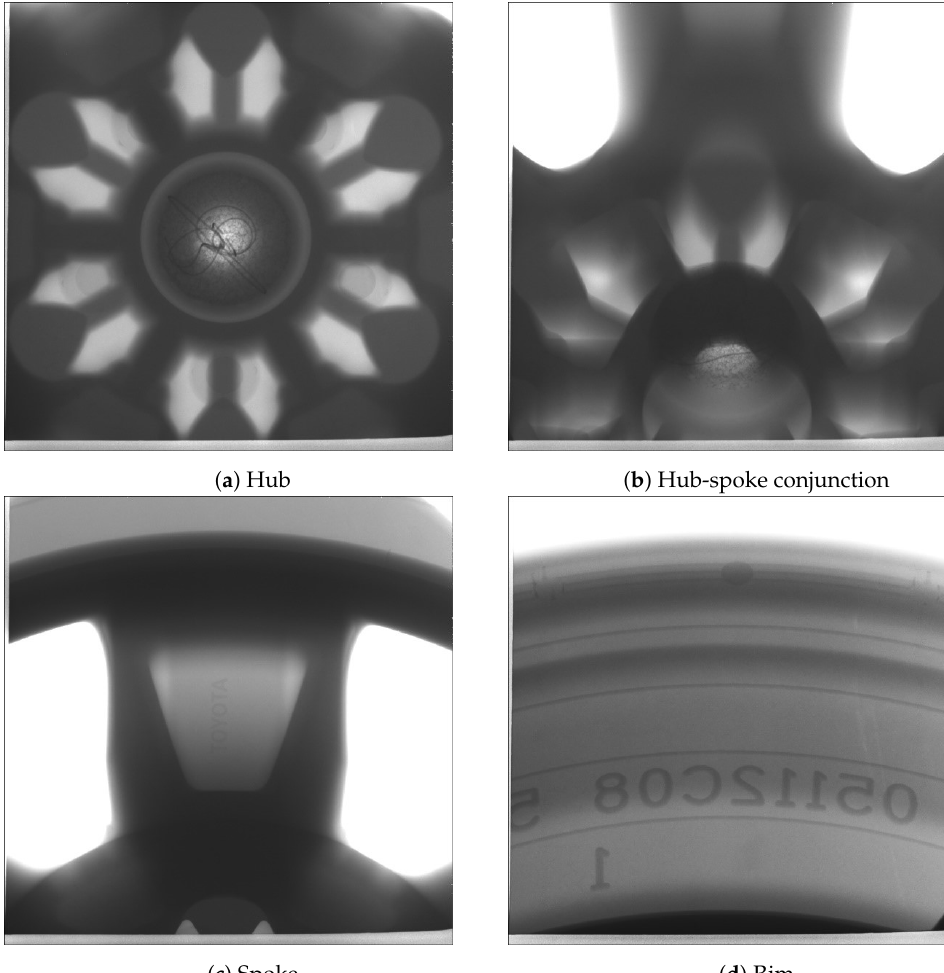
Figure 15. X-ray images of the wheel selected from the production process